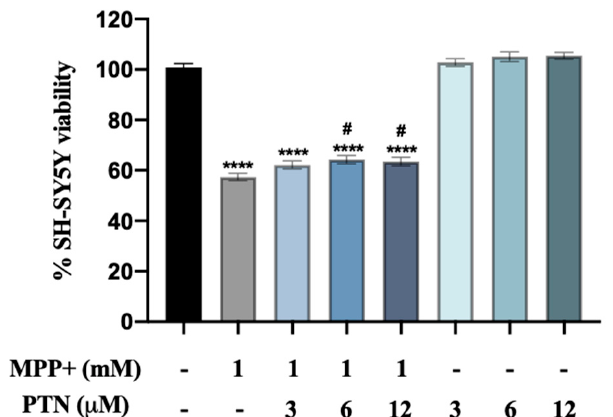
Figure 1. PTN modulates MPP+ -induced SH-SY5Y cell toxicity. MPP+ causes a significant decrease in SH-SY5Y viability which is partially prevented by co-incubation with PTN at 6 and 12 µM. **** p < 0.0001 vs. Control non-treated cells, # p < 0.05 vs. MPP+. Data are shown as % viability considering 100% viability of SH-SY5Y cells incubated with complete media (Control, black bar).